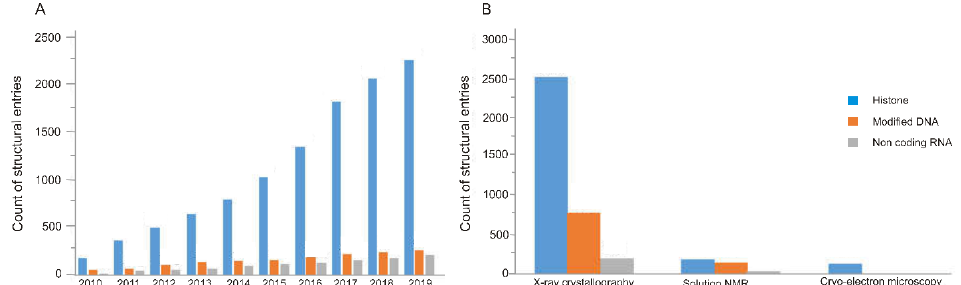
Figure 3. Trends of experimental structure determination of representative macromolecules of the epigenome. ( A ) The count of structural entries in the Protein Databank (PDB) per year (cumulative plot). ( B ) Distribution of entries of 2019 in ( A ) grouped by the main experimental techniques. The plots are based on a search in the PDB using key words ‘histone’, ‘modified DNA’ and ‘non-coding RNA’, which also involves ’siRNA’, ’miRNA’, ‘lncRNA’ were used in PDB. Accession date: 6 April 2020.